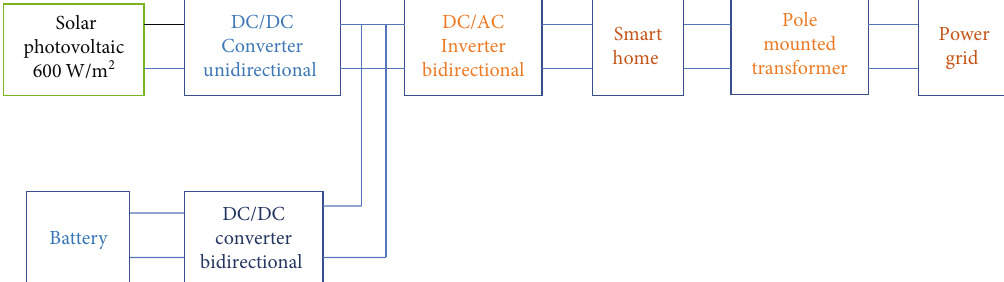
Figure 1: Block diagram of the system.